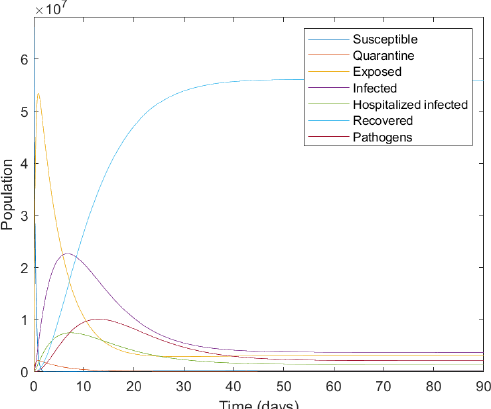
Figure 4. The simulation of human and pathogen population from 0 to 90 days. The dynamic of the susceptible population declines rapidly over a period of 0–3 days, with the initial population set at 66,170,000. This decline in population shifts to populations that are in the incubation period after exposure to the virus. The incubation period popula- tion dynamics are divided into two types: quarantine class, and exposed class, as shown in Figure 5a,b respectively. The dynamics of the quarantine and exposed class increase rapidly over the period of 0–1 day. The maximum population of the quarantine class is approximately 2,200,000, which is less than the maximum population of the exposed class of approximately 53,000,000. After day 1, the dynamics of both populations decline rapidly.